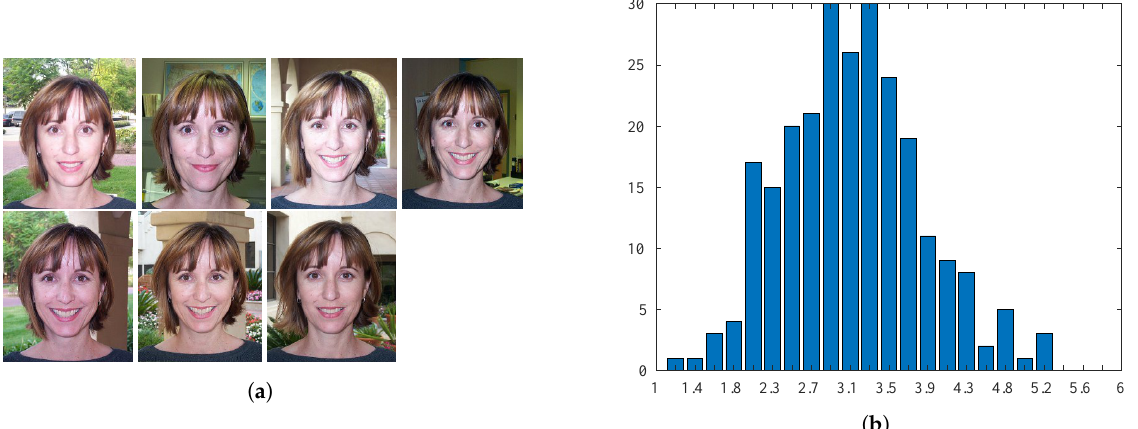
Figure 9. Sample images and distribution of scores for the Human Faces Score (HFS) database. ( a ) Samples are sorted by their aesthetic score (increasing from top left to bottom right). ( b ) Distribution of ground-truth